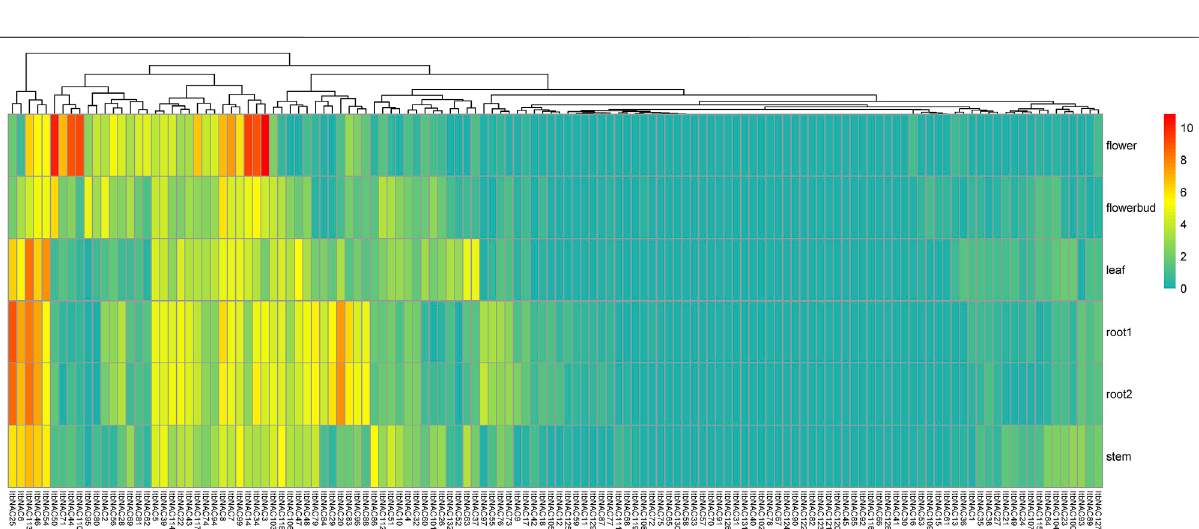
Frontiers in Genetics |